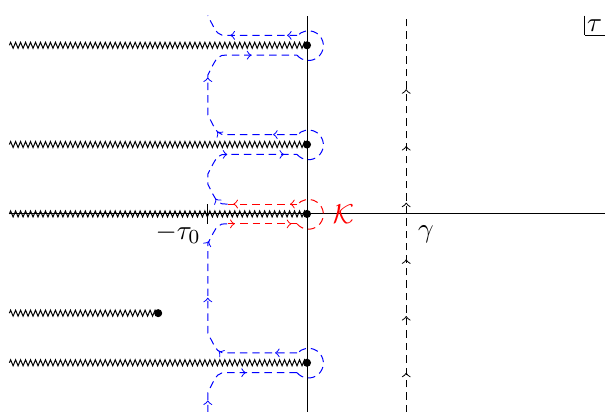
Figure 7. A sketch of the generic singularity structure of g (cid:15) ( τ ) The singularities are generically branch points, and the cuts are oriented away from the region < τ > 0 , where the correlator is analytic. The black dashed contour is the original one in eq. (3.31), while the blue dashed one is shifted to the left in order to leverage the exponential suppression at large Λ . Finally, the red contour is K in eq.